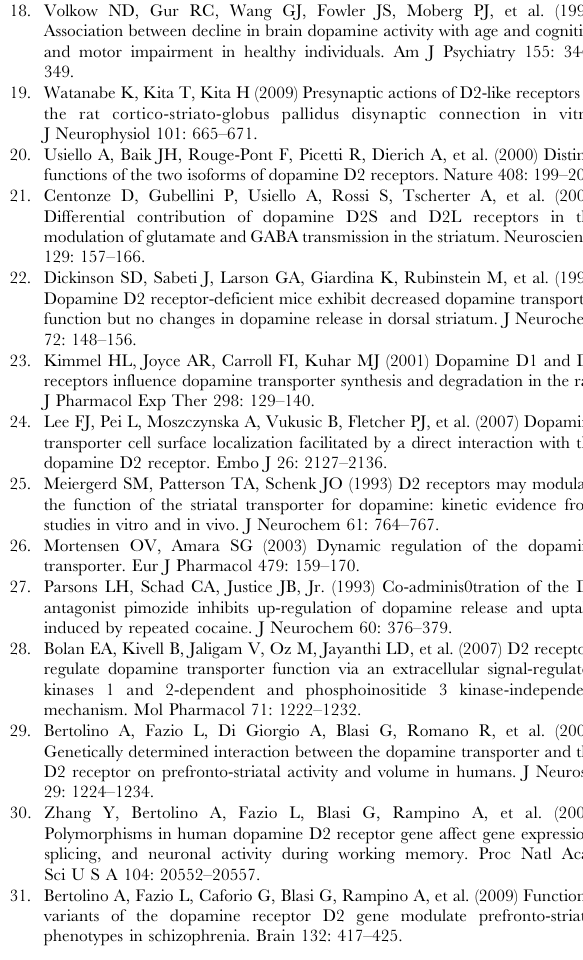
Table S2 Results from the correlation between 2-Back WM activity and the basal ganglia SPECT factor score that were not corrected for multiple comparisons. No clusters survived the statistical threshold in the inverse correlations.